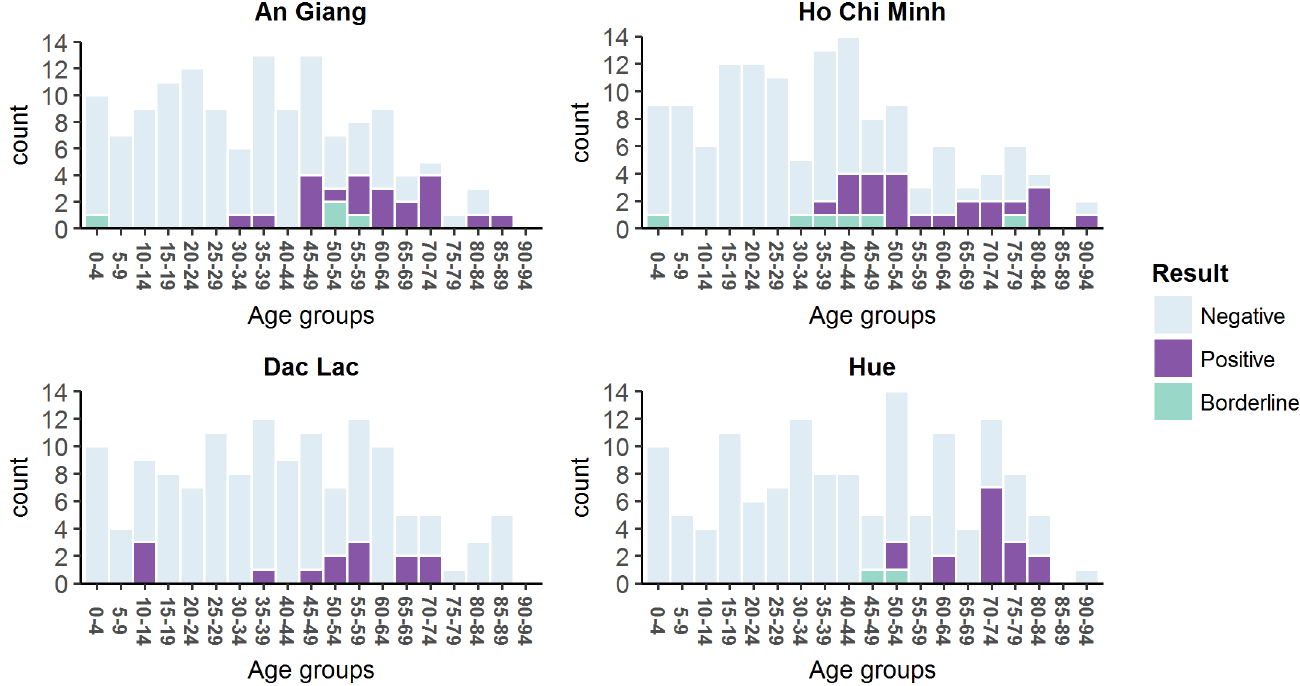
Fig 3. The stacked barplots of the numbers of negative, positive, borderline ELISA results by age group in each location: An Giang province, Ho Chi Minh City, Dak Lak province, and Hue City. The colored bars represent the negative, positive, and borderline respectively (as shown in the legend).